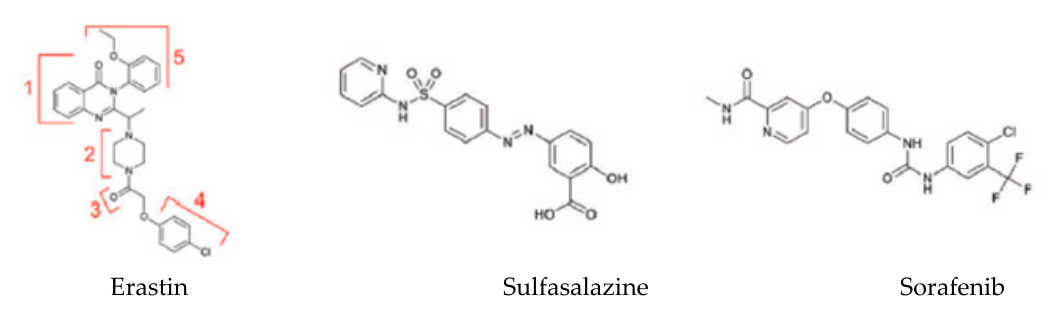
Figure 3. Exogenous ferroptosis inducers [49].